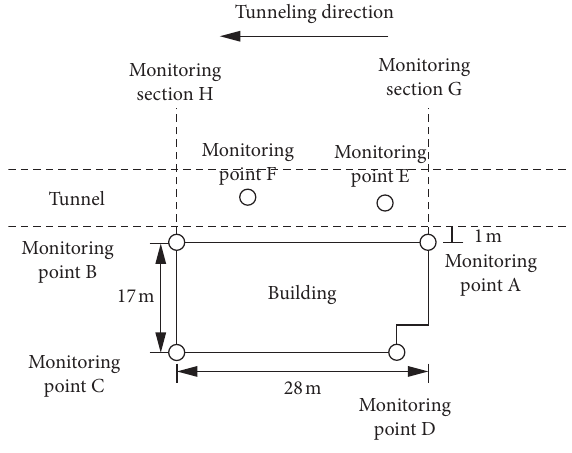
Figure 3: Layout of the